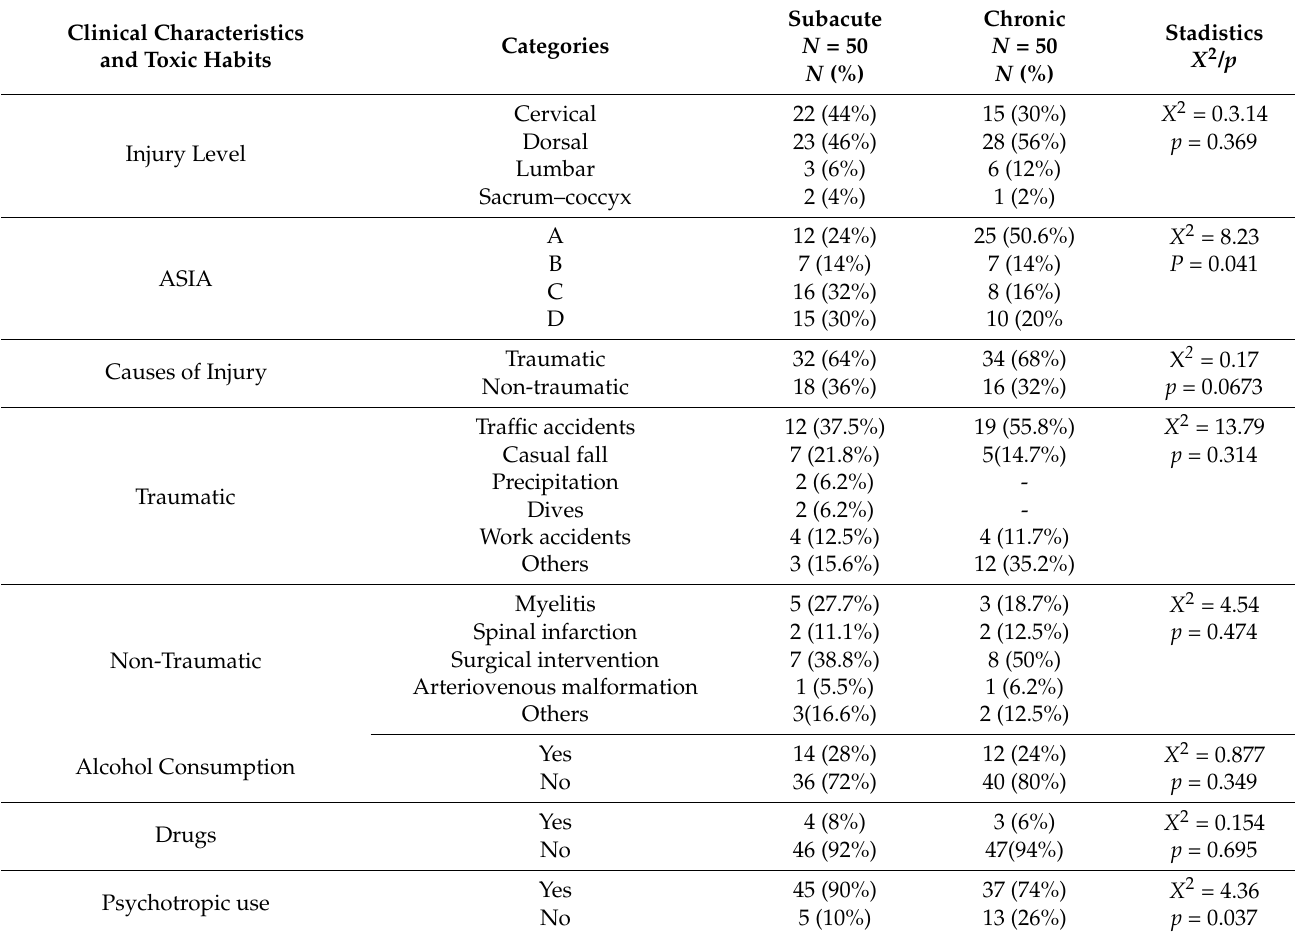
Table 2. Clinical characteristics and toxic habits of SCI